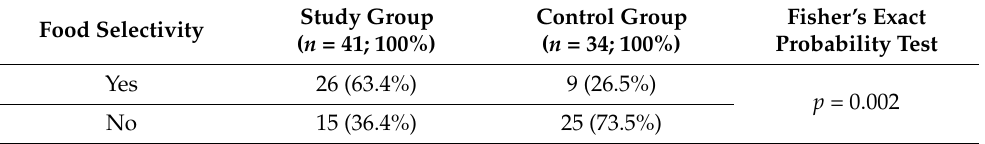
Table 8. Food selectivity in children in the Study Group and the Control Group (question II/13).